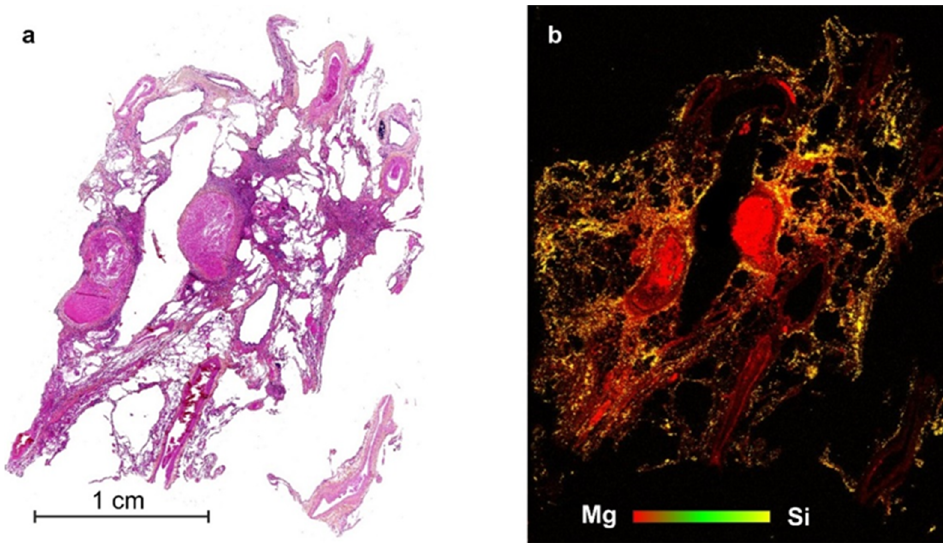
Figure 20. Example of human lung sample analysis, extracted from Reference [227], obtained from a patient who underwent lung transplantation for emphysema. ( a ) Histological image of the lung. ( b ) Corresponding LIBS multi-elemental images of Si and Mg. In this sample, Mg (red pixels) is used as an internal control representing the tissue. This picture shows the very high concentration of silica (yellow pixels), in the lung tissue, in a patient who, during her past occupational history, performed sandblasting during 1 year in very poor conditions.